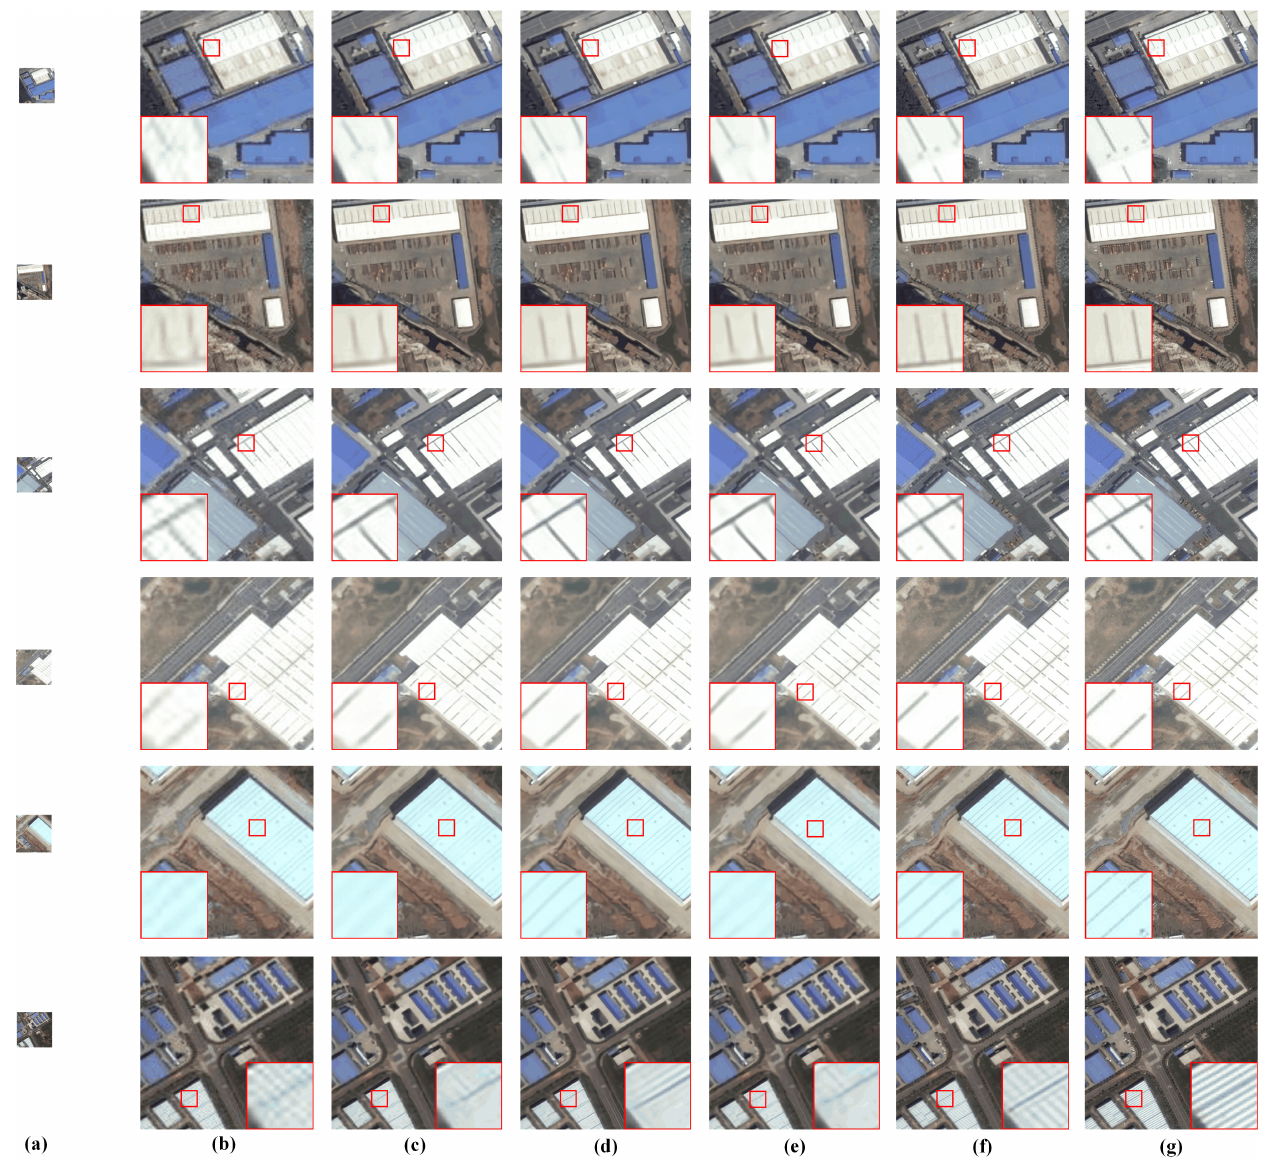
Figure 9. Visual comparisons of super-resolution results for different methods. ( a ) LR. ( b ) Bicubic. ( c ) EDSR. ( d ) WDSR. ( e ) CTN. ( f ) Proposed EDWSR. ( g )